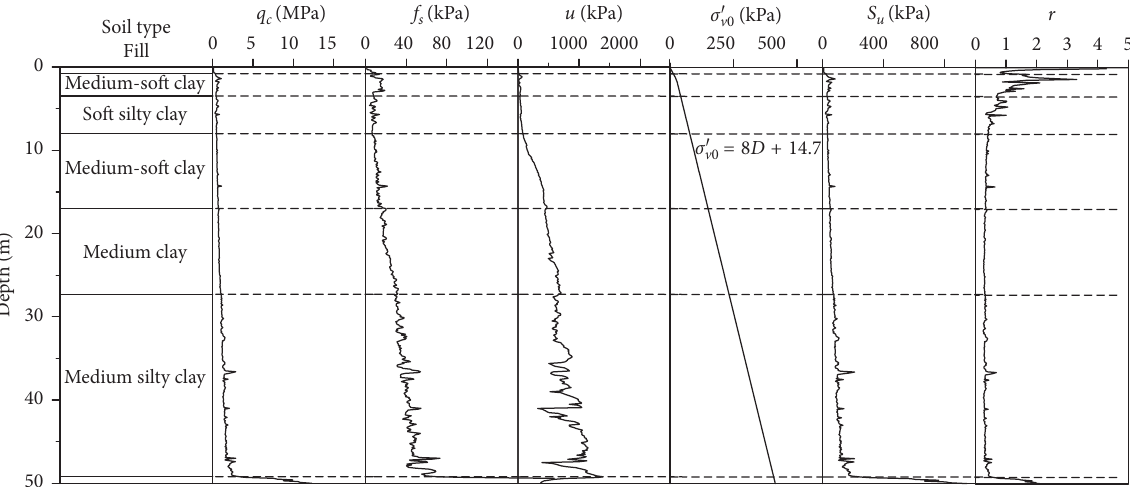
Figure 2: Soil profiles and CPT data at the Yili station.